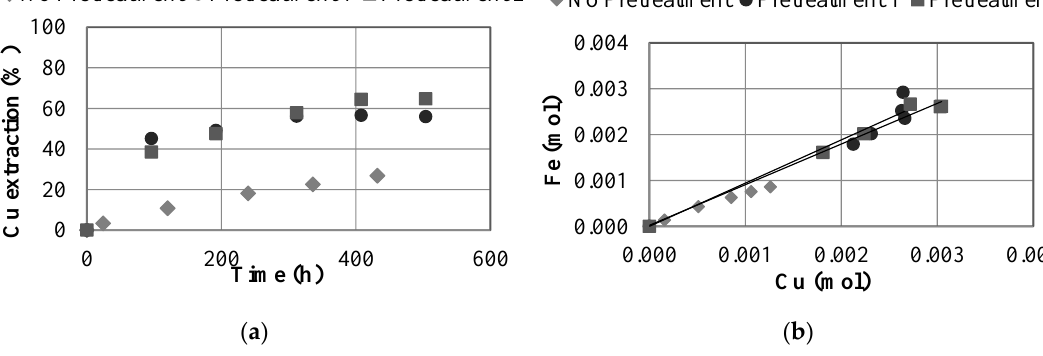
Figure 11. ( a ) Copper extraction (%) versus time (h) with pretreatment conditions. ( b ) Cu/Fe molar seawater as dissolvent, −150 + 75 µm, S/L ratio 2 g/L, 45 °C, 350 rpm, sample A.